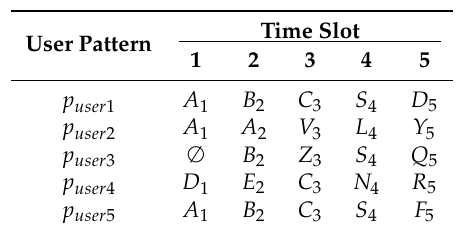
Table 2. Examples of individual mobility